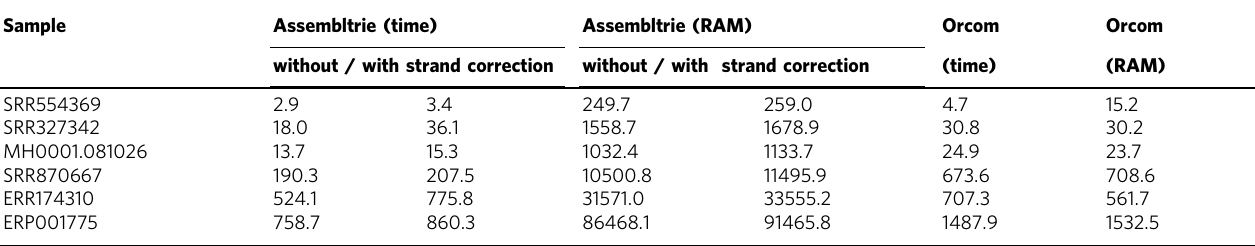
Table 4 Decompression times and memory usage of Assembltrie and Orcom Sample